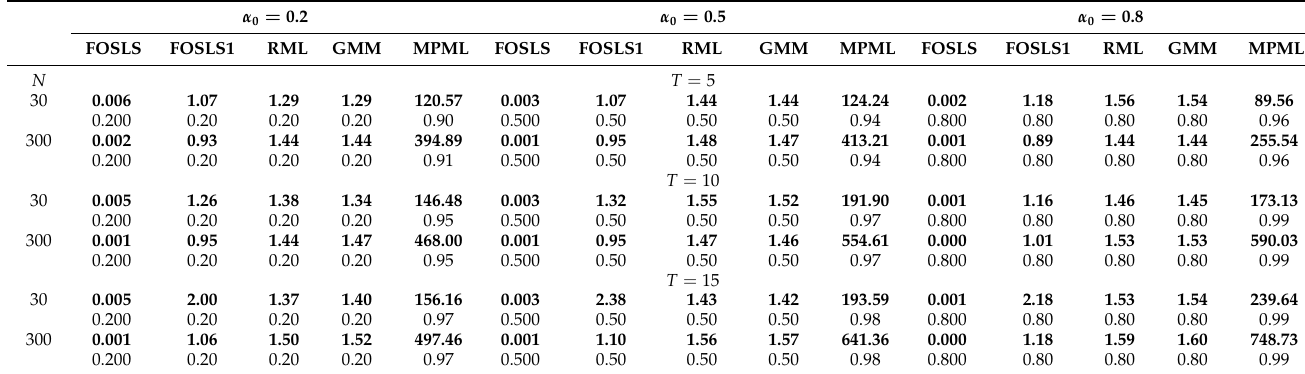
Table 1. The MAD of FOSLS and relative MAD (bold font) of all other estimators, and their Median (regular font) for nonnormal-nonstationary